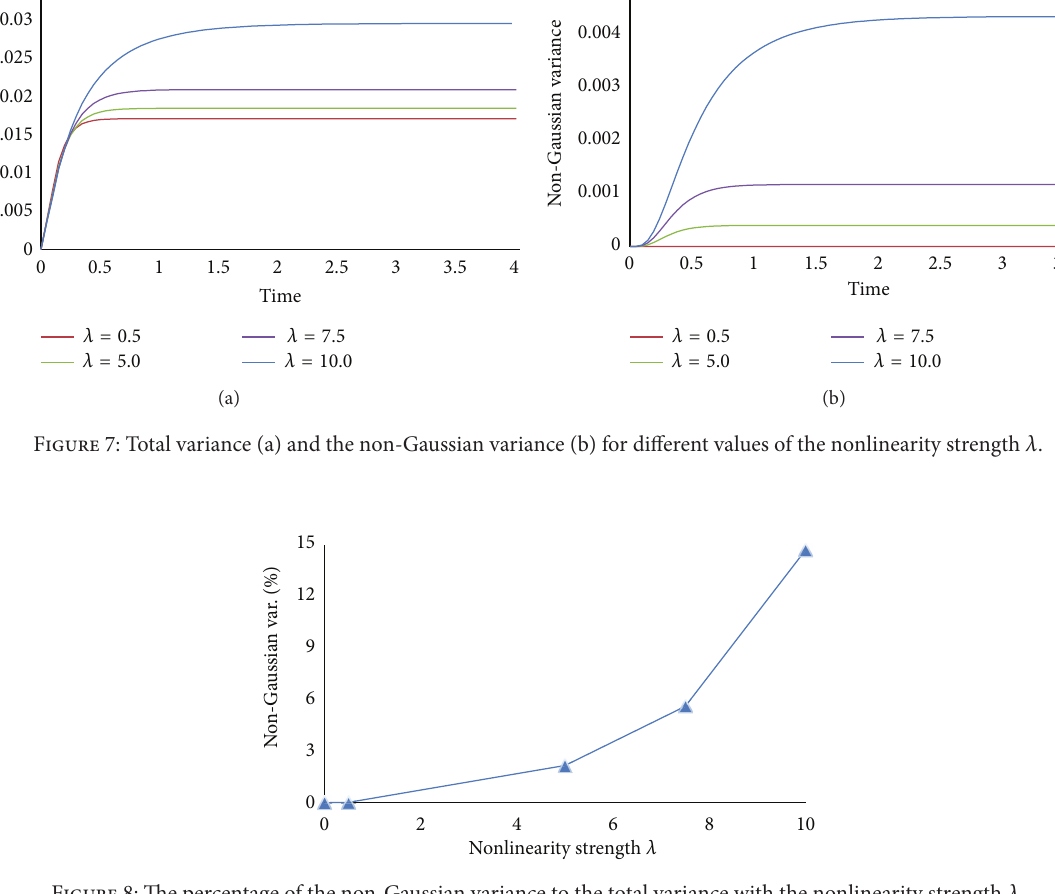
of existence of nonlinearities. Figure 7 shows comparison between the total variance (Gaussian and non-Gaussian) and the non-Gaussian variance of the solution at x =